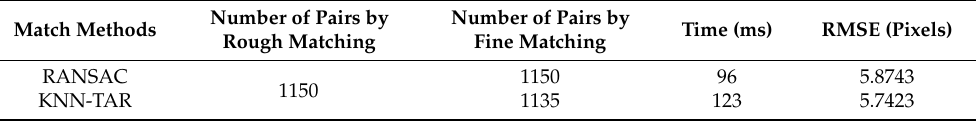
Figure 8. The stitched GF-1 image. Table 2. Comparison of the KNN-TAR and RANSAC algorithms for GF-2